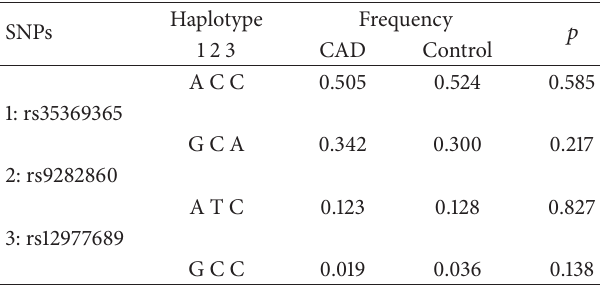
Table 4: Haplotype analyses in patients with CAD and control subjects.